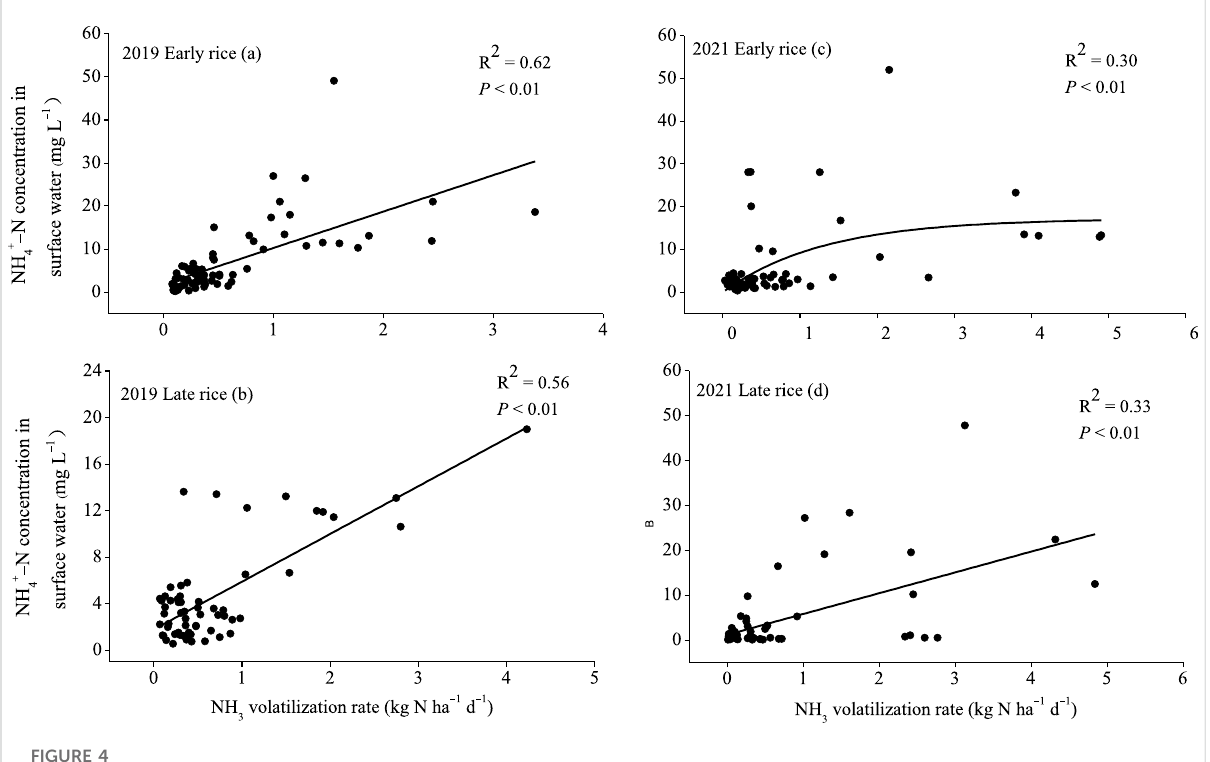
FIGURE 4 The relationship between NH 3 volatilization rates and NH 4 + – N concentrations in surface water for early (A,C) and late rice (B,D) in 2019 (A,B) and 2021 (C,D) .